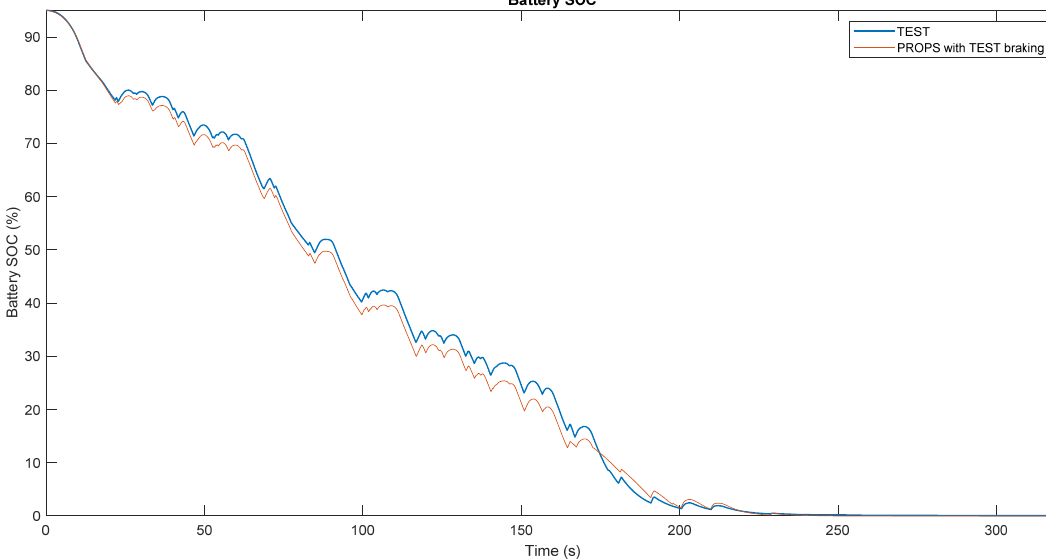
Figure 23. TEST (in blue) and PROPS (in red) battery power (in kW) vs. Lap Time (in seconds).